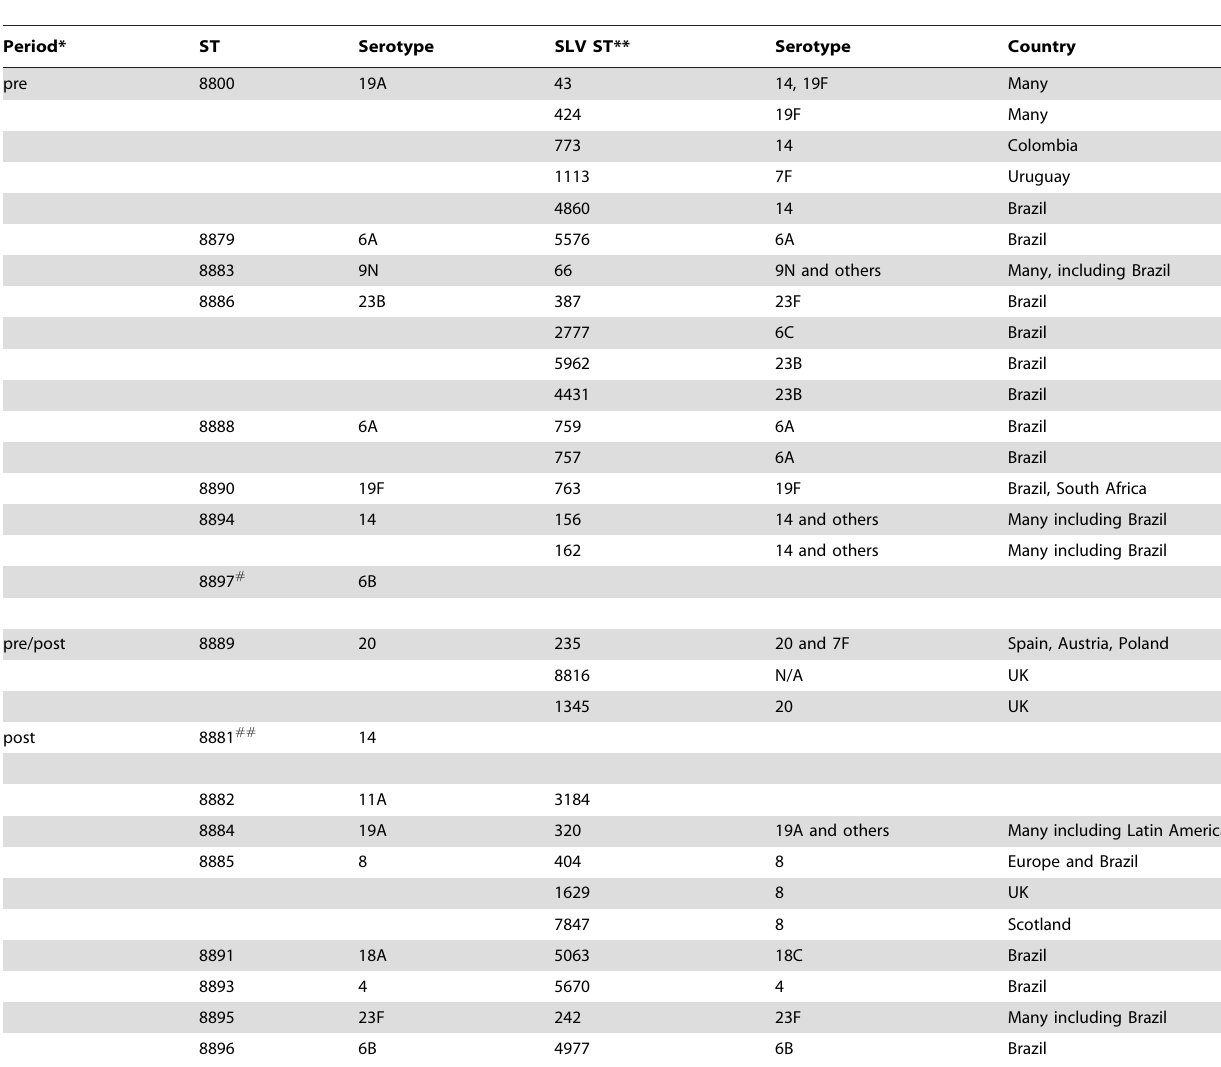
*Pre: pre-vaccination; Post: post-vaccination; **More frequent ST and/or the ones isolated in Brazil; # 8897 is DLV of STs 2781 (serotype 6B) and 8248 (serotype 6A/B), isolated previously in Brazil; ## 8881 is DLV of STs 9 (serotype 14) and 15 (serotype 14). The first ST was previously isolated in many countries, as the second one, which was also related to Brazilian isolates.